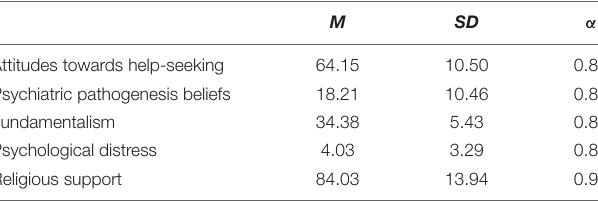
TABLE 1 | Descriptive summary of the questionnaire